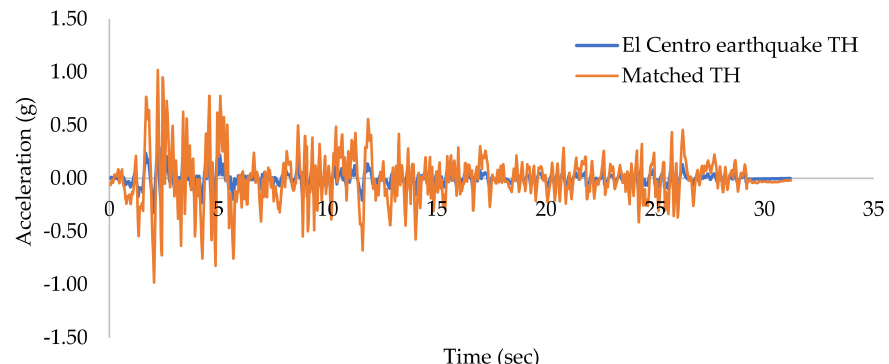
Figure 3. El Centro earthquake time history.